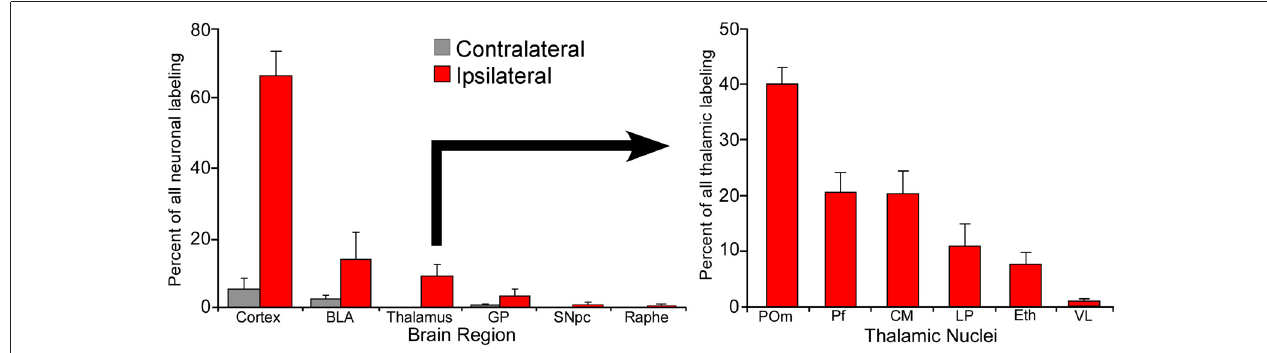
FIGURE 4 | Proportion of labeled neurons in different brain regions after injecting a retrograde tracer into the right DLS of seven rats. More than 70% of the projections originate from the two cortical hemispheres, nearly 20% from the basolateral amygdala (BLA), and 10% from the thalamus. Among thalamic neurons that project to DLS, 40% reside in the medial part of the posterior nucleus (POm). Adapted from Smith et al.